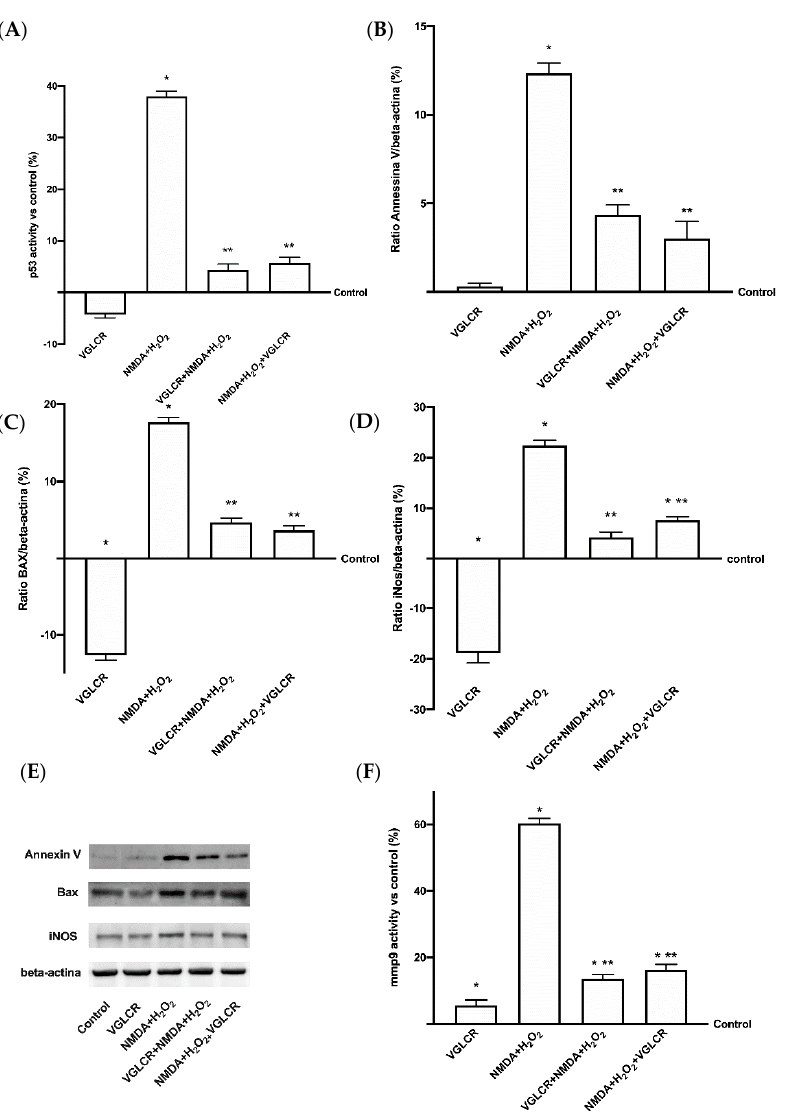
Figure 3. Western blot, densitometric analysis, and ELISA activity of main intracellular glaucoma markers. In ( A ) p53 activity measured by ELISA test; in ( B ) densitometric analysis of Annexin V; in ( C ) densitometric analysis of Bax; in ( D ) densitometric analysis of iNOS; in ( E ) Western blot of Annexin V, Bax, and iNOS; (F) MMP9 activity measured by ELISA test. All these markers were measured with NMDA+H 2 O 2 before or after VGLCR stimulations. The results are expressed as means ± SD (%) vs control (0% line) of 4 independent experiments, each performed in triplicate. Densitometric analysis are expressed as means ± SD (%) of 4 independent experiments, normalized and verified by β -actin detection. The images shown are an example of each protein from 4 independent experiments. * p < 0.05 vs. control; ** p < 0.05 vs. NMA+ H 2 O 2 . The abbreviations are the same as used in Figure 1.